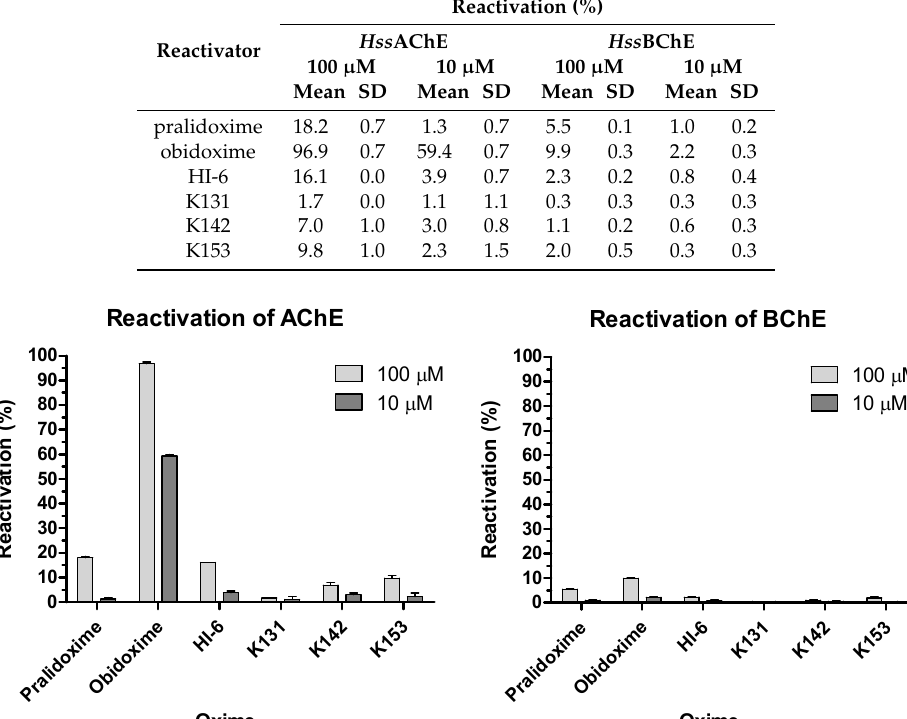
Figure 3. Reactivation of POX-inhibited Hss AChE and Hss BChE by novel bisquaternary aldoxime reactivators.